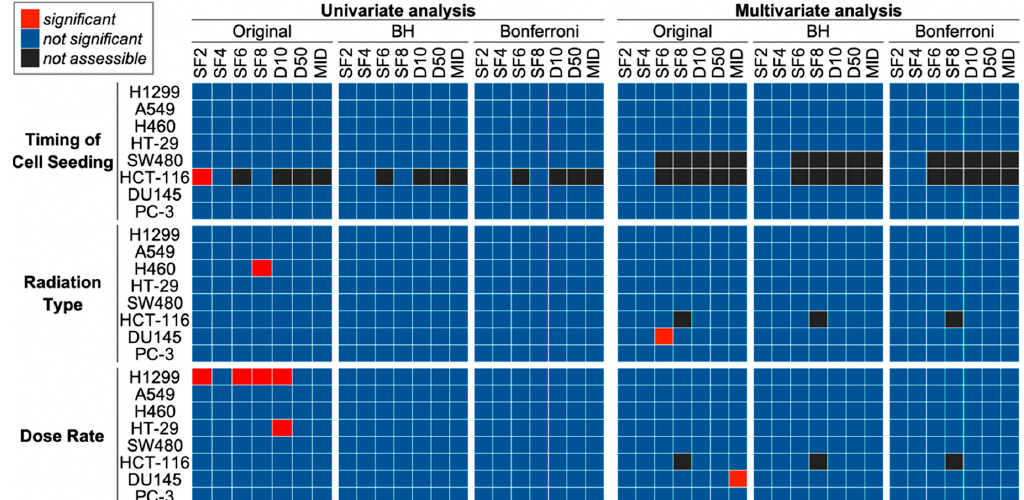
Figure 5. Univariate and multivariate analyses of the influence of experimental setting on clonogenic survival. For univariate analysis, differences in SF 2 , SF 4 , SF 6 , SF 8 , D 10 , D 50 , or the mean inactivation dose (MID) between different timings of cell seeding (i.e., before irradiation vs. after irradiation) or between different radiation types (i.e., X-rays vs. γ -rays) were examined using the Mann–Whitney U test. The correlation between dose rate and SF 2 , SF 4 , SF 6 , SF 8 , D 10 , D 50 , or 𝐷 was examined using Spearman’s rank correlation test. For multivariate analysis, the effect of timing of cell seeding, radiation type, and dose rate on SF 2 , SF 4 , SF 6 , SF 8 , D 10 , D 50 , or 𝐷 was examined by multiple linear regression. Original panels show statistical significance ( p value < 0.05) after initial analyses. BH and Bonferroni panels show statistical significance after Benjamini–Hockberg and Bonferroni correction, respectively. Black panels, statistical test not applicable due to insufficient sample size.